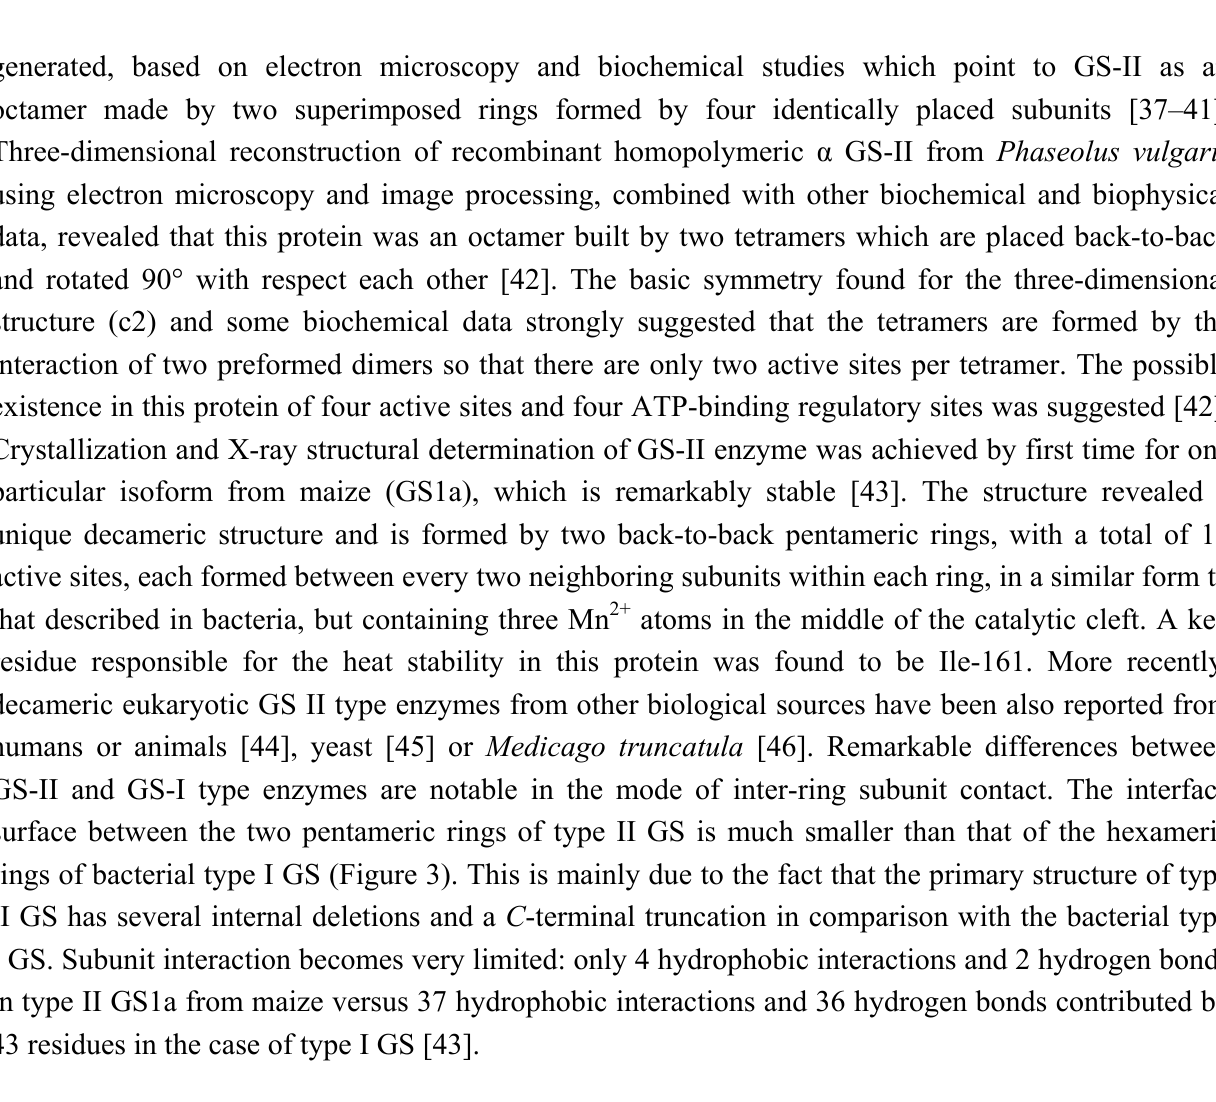
Figure 3. Differences in the amount of inter-ring subunit interactions of type I and type II Salmonella typhimurium GS (type I GS) compared to GS1a from maize (type II GS)